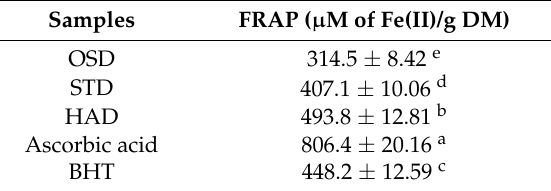
Figure 4. Effect of different drying methods on DPPH activity in ginger extracts. OSD: sun drying, STD: solar tunnel drying and HAD: hot air drying. Bars indicate standard deviation of triplicate measurements. Table 2. FRAP activity of ginger extracts, dried with different methods.